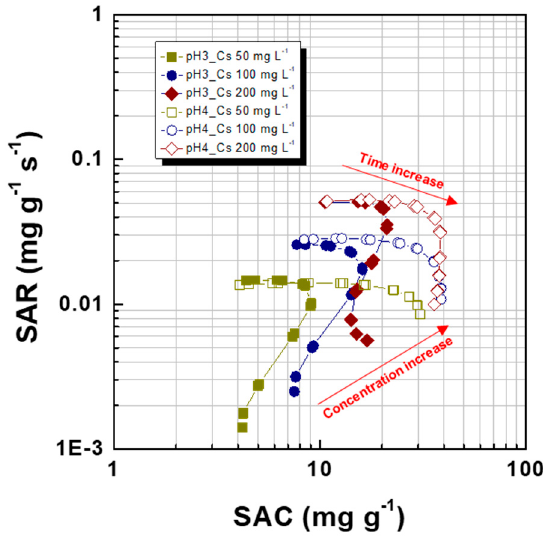
Figure 8. Changes in Cs + concentration ( a ), and pH of effluent ( b ) according to pH in the influent (Experimental conditions: Influent of 200 mg L − 1 Cs + ions concentration was fed with a flow rate of 20 mL min − 1 at 1.2 V for 60 min adsorption).